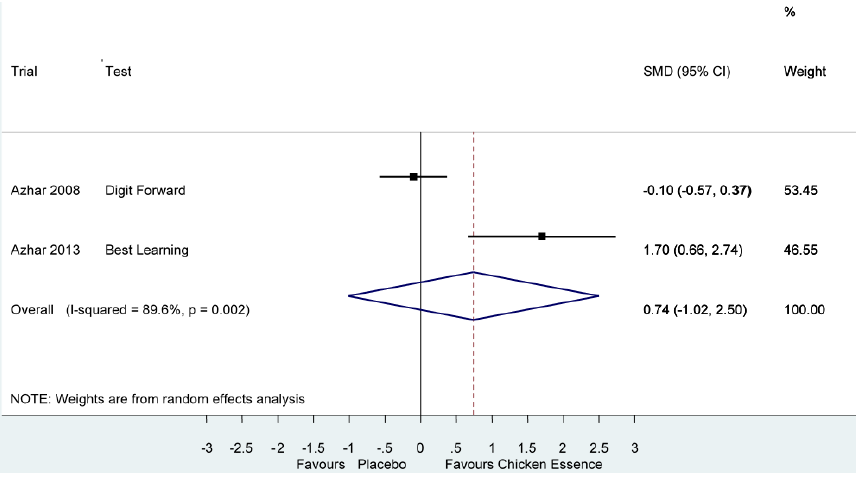
Figure D4. Pooled effect estimate of score of short-term memory tests (with Azhar’s test removed [14]).